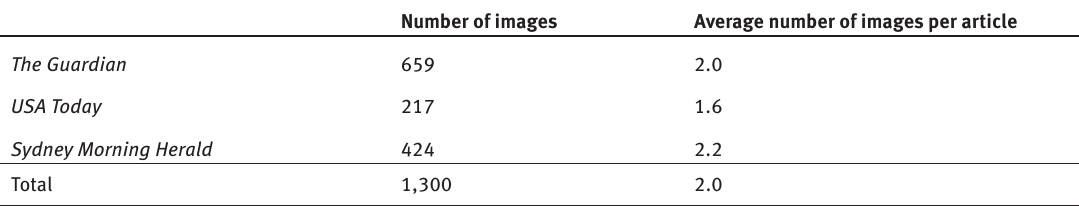
Table 2: The frequency of images in the corpus